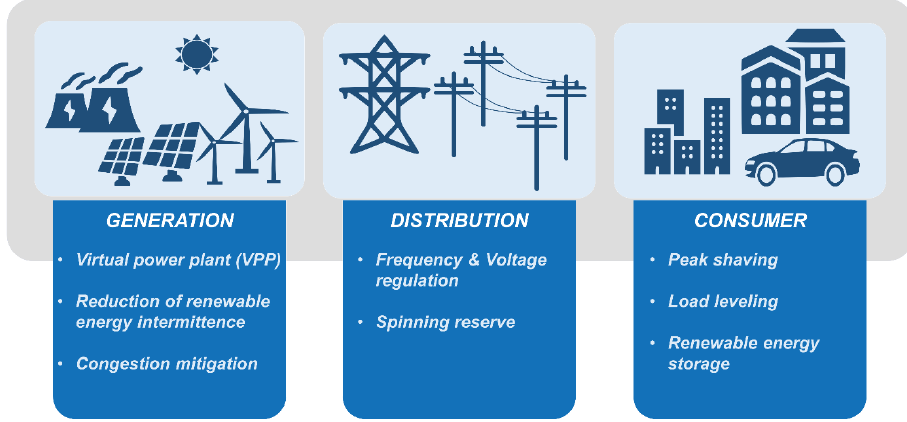
Figure 2. Potential services of V2G for different levels of the grid.